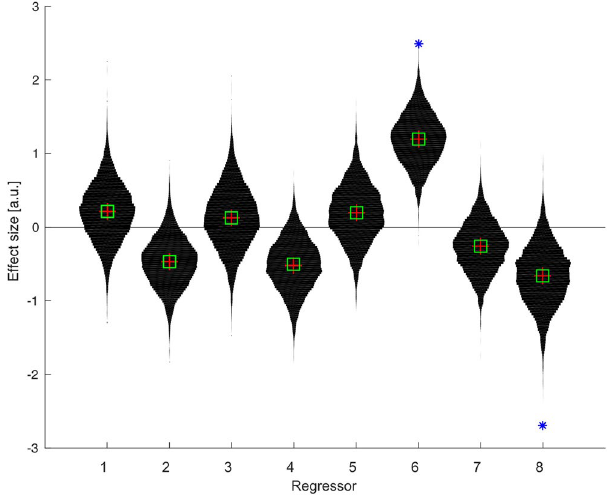
Figure 2. Violin plot of the 8 fixed effect regression coefficients (beta) of the mixed effects model where participants are clustered within villages. The red cross indicates the mean of each distribution, while the square is the median. Predictors: 1. Diet score, 2. Earnings, 3. Economic score, 4. Education (years), 5. Food insecurity, 6. Sex, 7. Size of last meal, 8. TV consumption